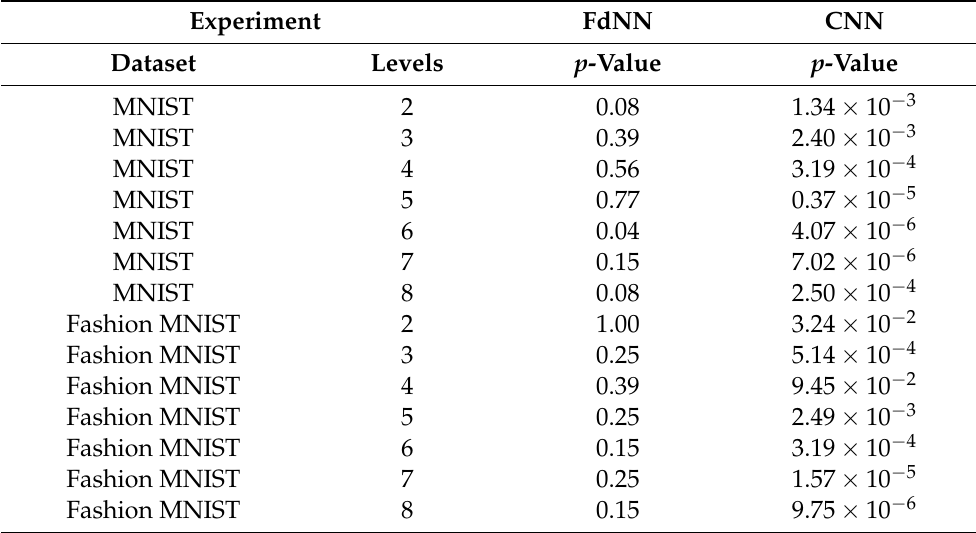
Table 11. Kruskal–Wallis Rank Sum Test between CNNs comparing results obtained by using less than 4096 synapses and between 4096 and 8192 synapses for each simulation experiment using quantization levels between 2 and